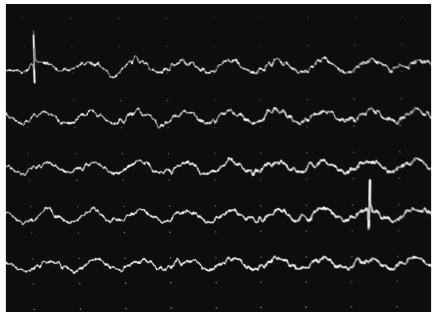
Figure 3: LEMG of the denervated TA